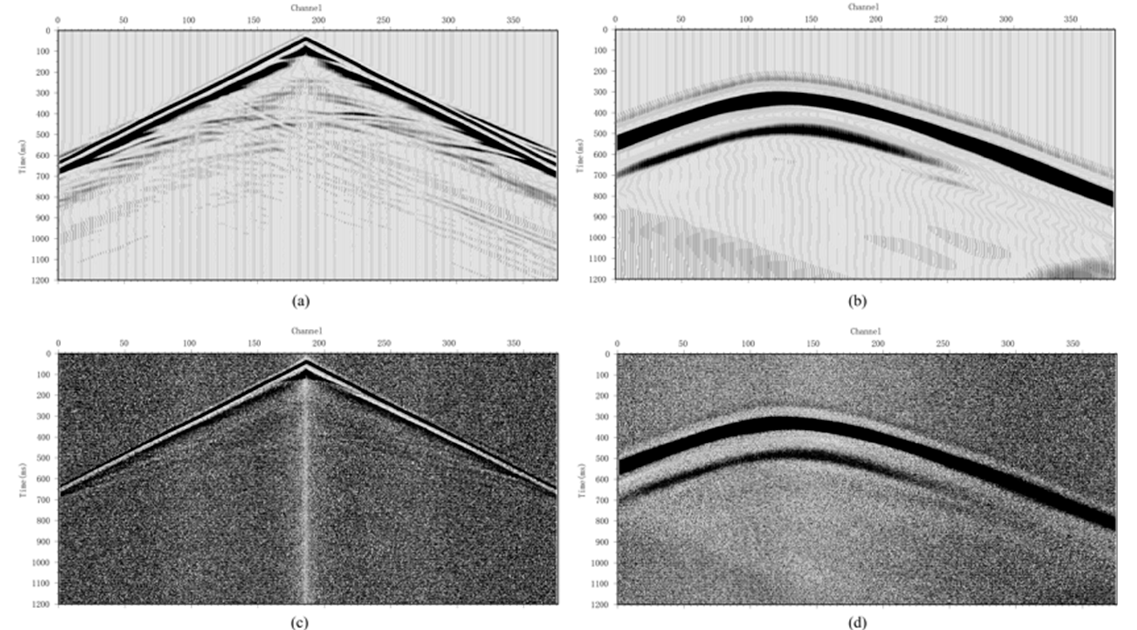
Figure 2. Example of shot gathers of the active and passive synthetic seismic datasets used in this work. ( a ) An example of the active shot gather. ( b ) An example of the passive shot gather. ( c ) An example of the active shot gather with noise. ( d ) An example of a passive shot gather with noise. Table 1. Modeling parameters for the active and passive seismic datasets. Parameters/Data Sets